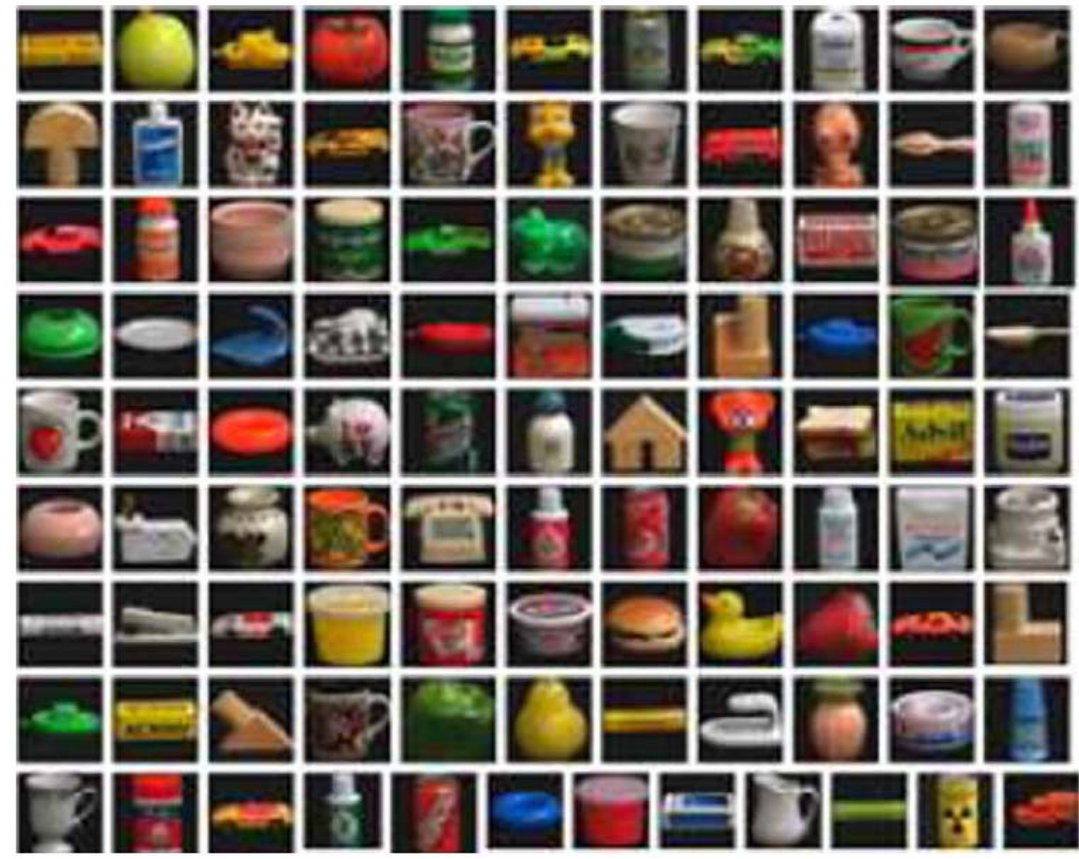
Fig.14. A sample of coil